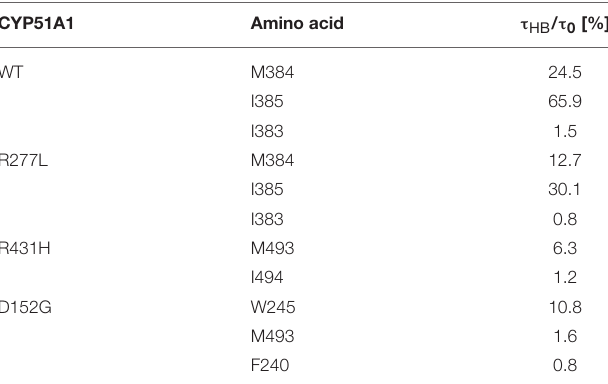
TABLE 5 | Relative occupation times of lanosterol’s hydroxyl group and its hydrogen bond formed with a given residue (amide group of the protein backbone) during production run (20